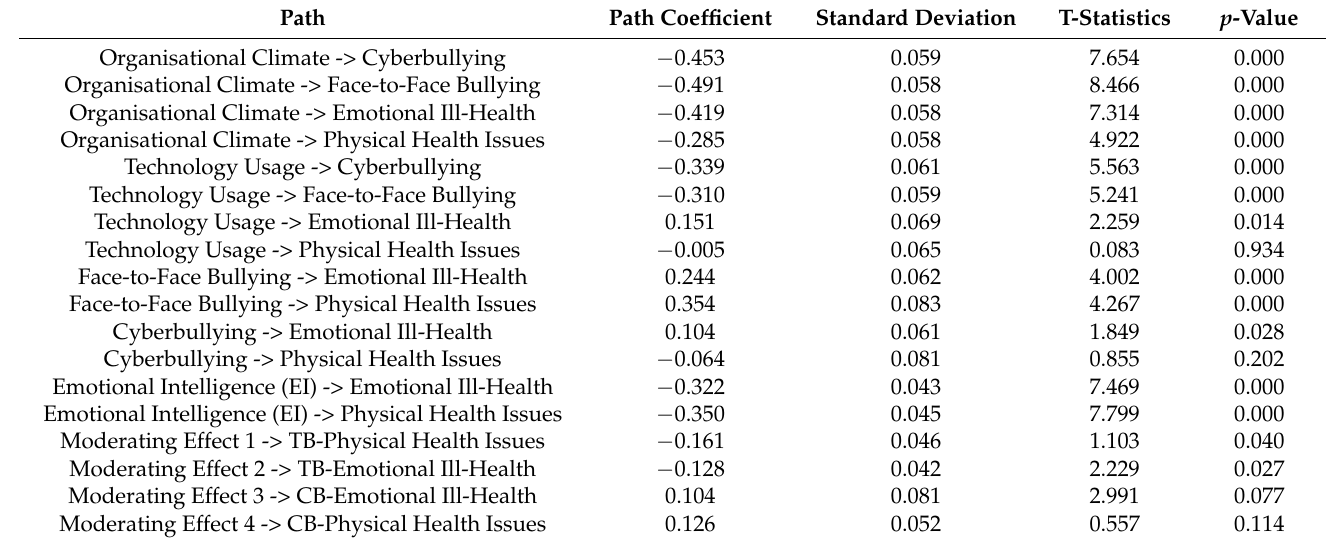
Table 7. Hypothesis testing